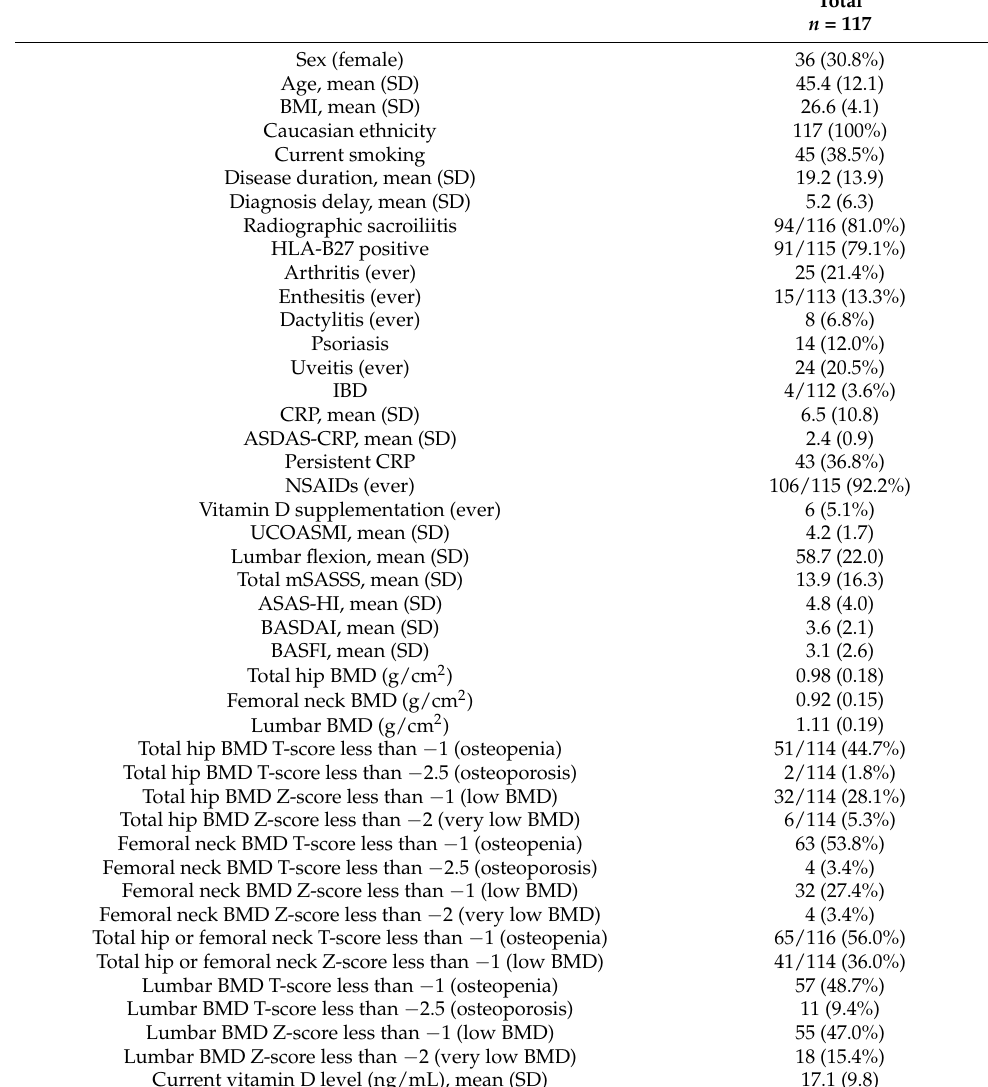
Table 1. Descriptive data of the included